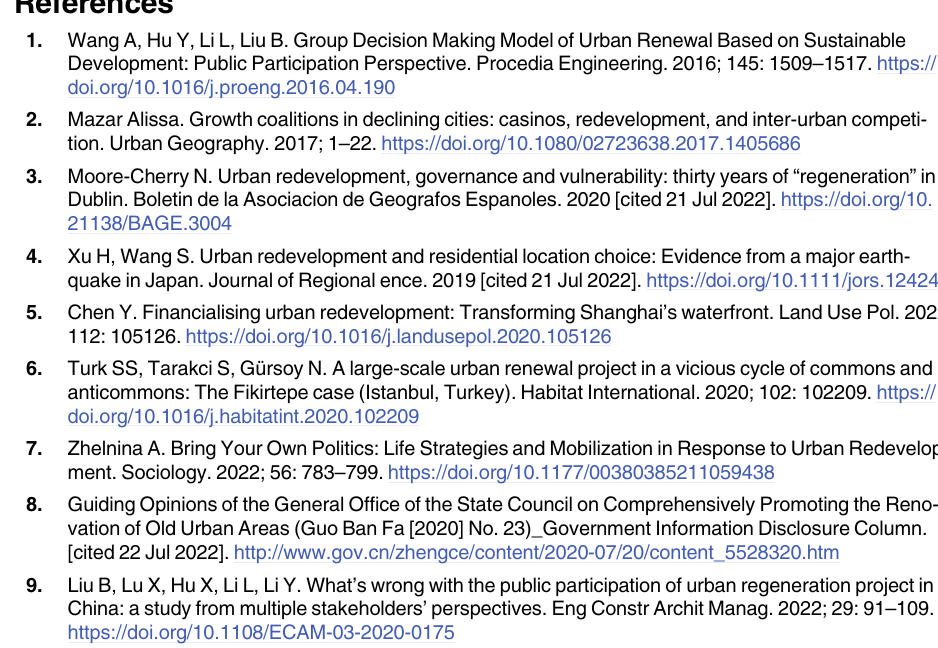
S1 Table. 466 Chinese forum websites and 42 Chinese government affairs